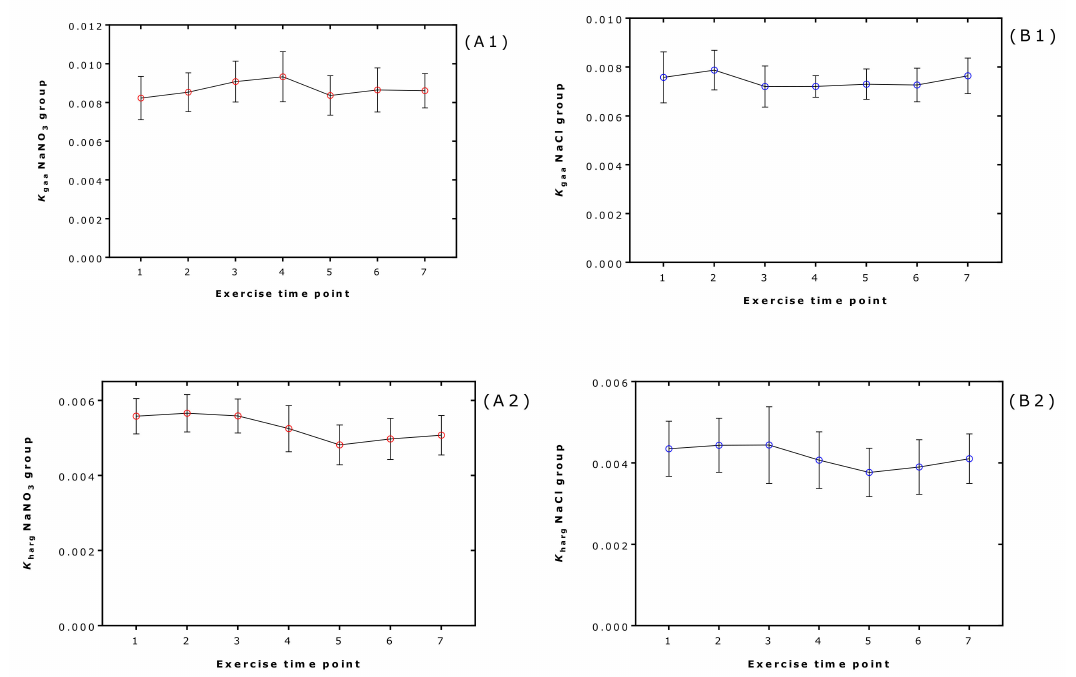
Figure 4. K gaa , K harg , and K gaa / K harg values of the volunteers of the NaNO 3 group ( A1 , A2 ) and of the NaCl group ( B1 , B2 ) at the seven individual timepoints of exercise after supplementation (see Scheme 2). The number of the samples was too small for the normality test; the data are shown as mean with standard error of the mean for the volunteers of the NaNO 3 and NaCl groups (see also Figure 3).